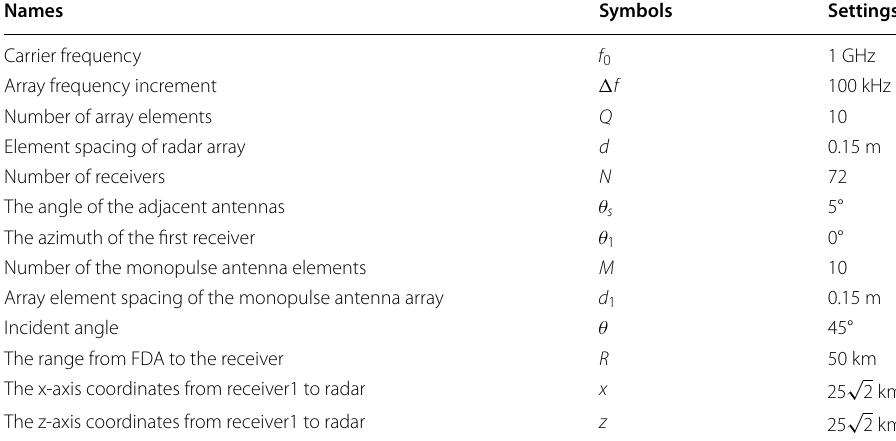
Table 1 Simulation settings